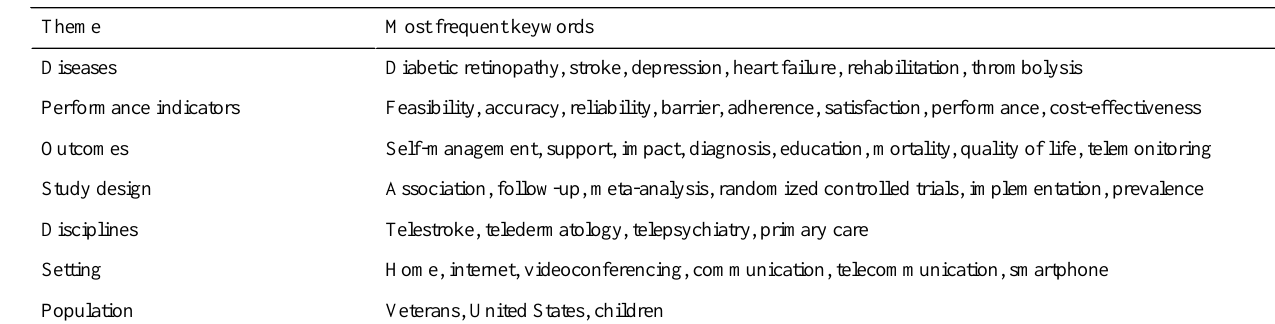
Table 1. Research keywords in telemedicine by theme.